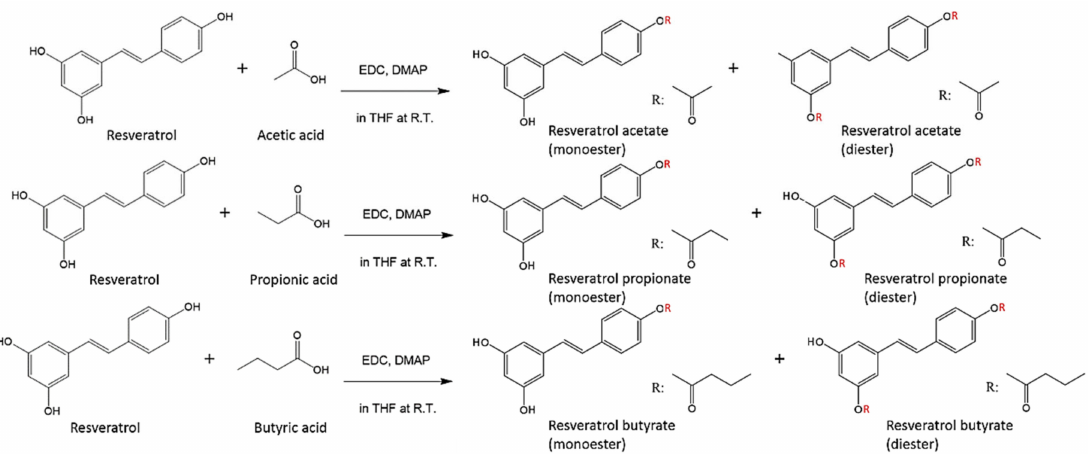
Figure 1. Reactions for the synthesis of resveratrol esters. EDC, 1-ethyl-3-(3-dimethylaminopropyl) carbodiimide; DMAP, 4-dimethylaminopyridine; THF, tetrahydrofuran; R.T., room temperature (28–30 ◦ C).